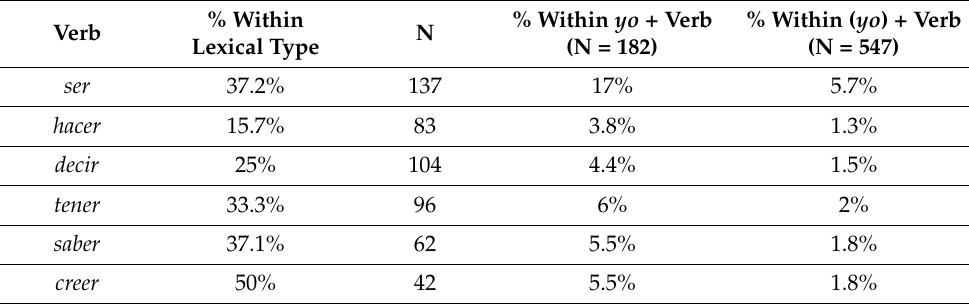
Table 6. Proportion of ( yo ) + frequent verb in the diachronic newspapers’ data. % Within yo + Verb % Within ( yo ) + Verb % Within N Verb (N = 182) (N = 547) Lexical Type ser 37.2% 137 17% 5.7% hacer 15.7% 83 3.8% 1.3% decir 25% 104 4.4% 1.5% tener 33.3% 96 6% 2% saber 37.1% 62 5.5% 1.8% creer 50% 42 5.5%